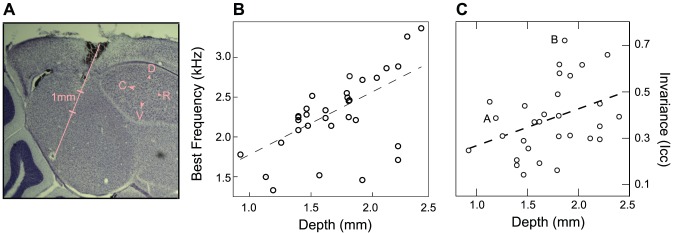
Location of noise invariant neurons in NCM.
A. Photomicrograph of Nissl-stained brain slice in one bird showing the typical trajectory of the electrode penetration. By carefully orienting our electrode angle, we were able to sample NCM along its entire dorsal to ventral extent. B. Scatter plot of noise invariance against stereotactic depth of neural recordings. Noise invariance and recording depth were significantly correlated (slope = 0.15/mm, adjusted R2 = 0.13, p = 0.02). The example neurons are labeled A and B on the scatter plot. C. Scatter plot showing the relationship between the best frequency (Y-axis) and the depth of the recording along the dorsal to ventral axis of NCM (X-axis). The solid line is the linear regression between these two variables (adjusted R2 = 0.34, p<10-3).